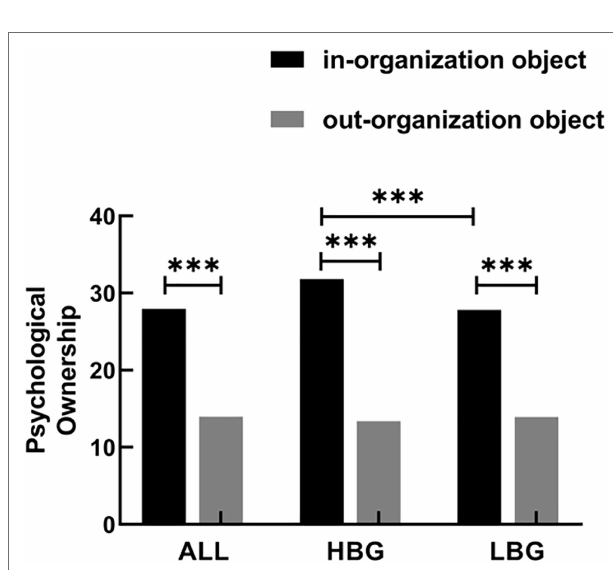
FIGURE 2 | Average scores for participants’ psychological ownership in study 1. “ ∗∗∗ ” represents that p < 0.01. Larger values on the vertical axis indicated stronger feelings of psychological ownership (range: 0–42). Self- reported psychological ownership scores for in-organization objects were significantly higher than those for out-organization